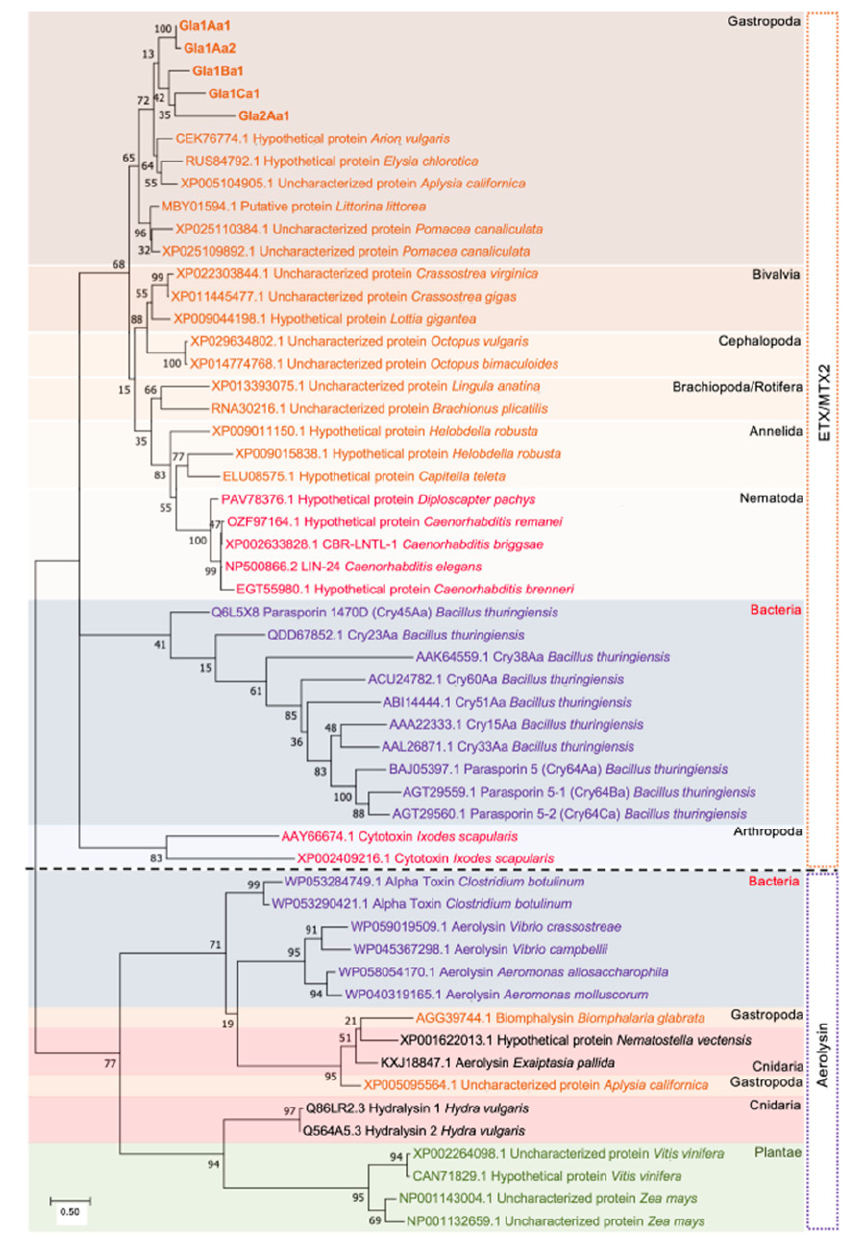
Figure 4. Phylogeny of the Glabralysins. Phylogenetic tree was constructed by ML method based on a JTT matrix-based model. The tree with the highest log likelihood is shown ( − 15,588.70). Bootstrap values higher than 0.15 are indicated at the corresponding node on the tree. The two main groups of toxins ETX and aerolysin are described by colored boxes flanked to the tree. Within the Lophotrochozoa group (underlined in orange), Ecdyzozoa (underlined in pink red), bacteria (underlined in purple), Cnidaria (underlined in cyan) and plantae (underlined in green). Orange degraded colored boxes represent successive clusters of Gastropoda, Bivalvia, Cephalopoda, Brachiopoda and Rotifera, Annelida, Nematoda . Purple background indicates bacteria. Red background indicates Cnidaria and green background regroup the Plantae. All Cnidaria species are colored in green and all Arthropoda in blue. For each protein, the accession number followed by the entry description and the species is indicated. Glabralysin sequences are indicated in bold. The scale bar indicates the number of substitutions per site and the tree is drawn to scale. Depending on the Glabralysins considered, a high level of variability could be observed in their primary structure alignment (Figure 2). To further characterize these variable regions, we performed a superimposition of the 3D structures of the five Glabralysins highlighting the levels of amino acid variability using CONSURF alignment tool. We identified that the most variable region is located in domain 1 (57% of variable amino-acids), while the most conserved are domains 2 and 3 (12% and 16% respectively) (Figure 5). This observation led us to suggest a potential variability in Glabralysin targets, as D1 is the recognition domain, which would be thus involved in different biological functions in B. glabrata .